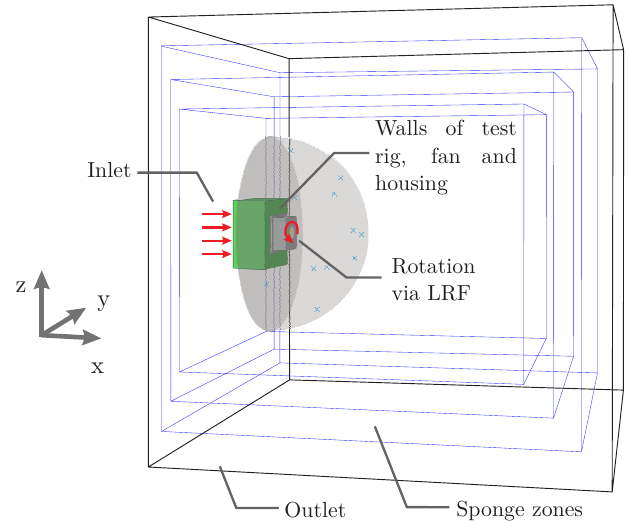
Figure 4. Schematic view of the simulation model and the boundary conditions.